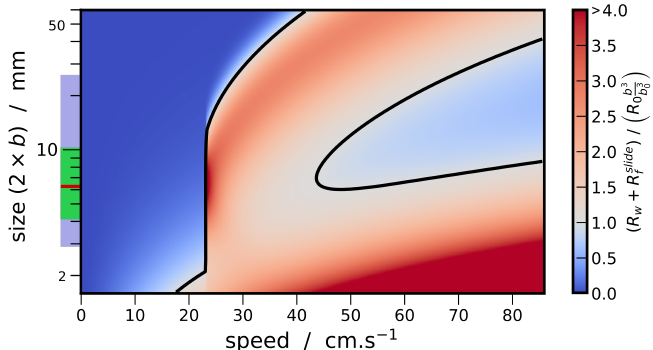
Figure 5. Total drag( R w + R slide v ) divided by the putative propelling force a whirligig beetle can exert ( R 0 b 3 ) as a function of its size and its speed. The black line indicates where the total drag equals b 3 0 the insect’s thrust. Thus the blue region where the drag-thrust ratio is below 1 delimits the speeds accessible. The range of sizes of whirligig beetles is highlighted in light blue on the axis, the green rectangle indicates the standard deviation of the size distribution around the mean, and the red line indicates the median.